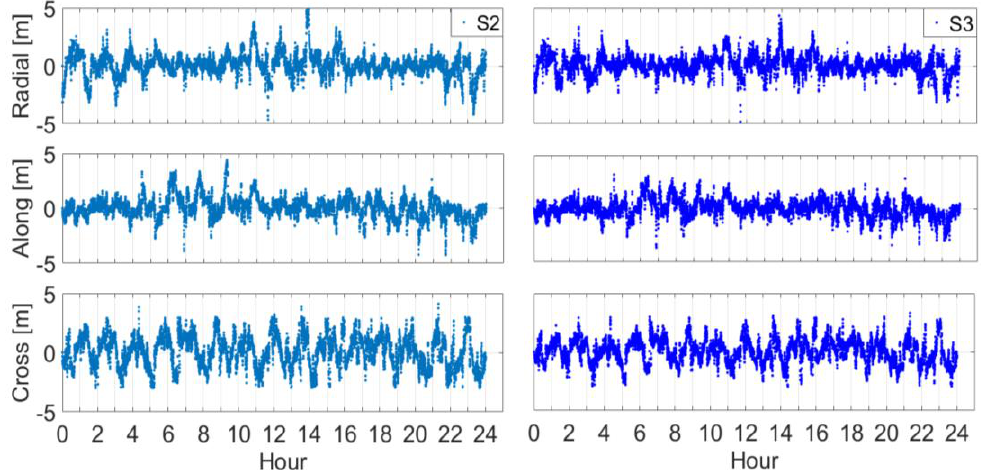
Figure 3. Swarm-A real-time POD results on a normal day of Schemes 2 ( left ) and 3 ( right ).